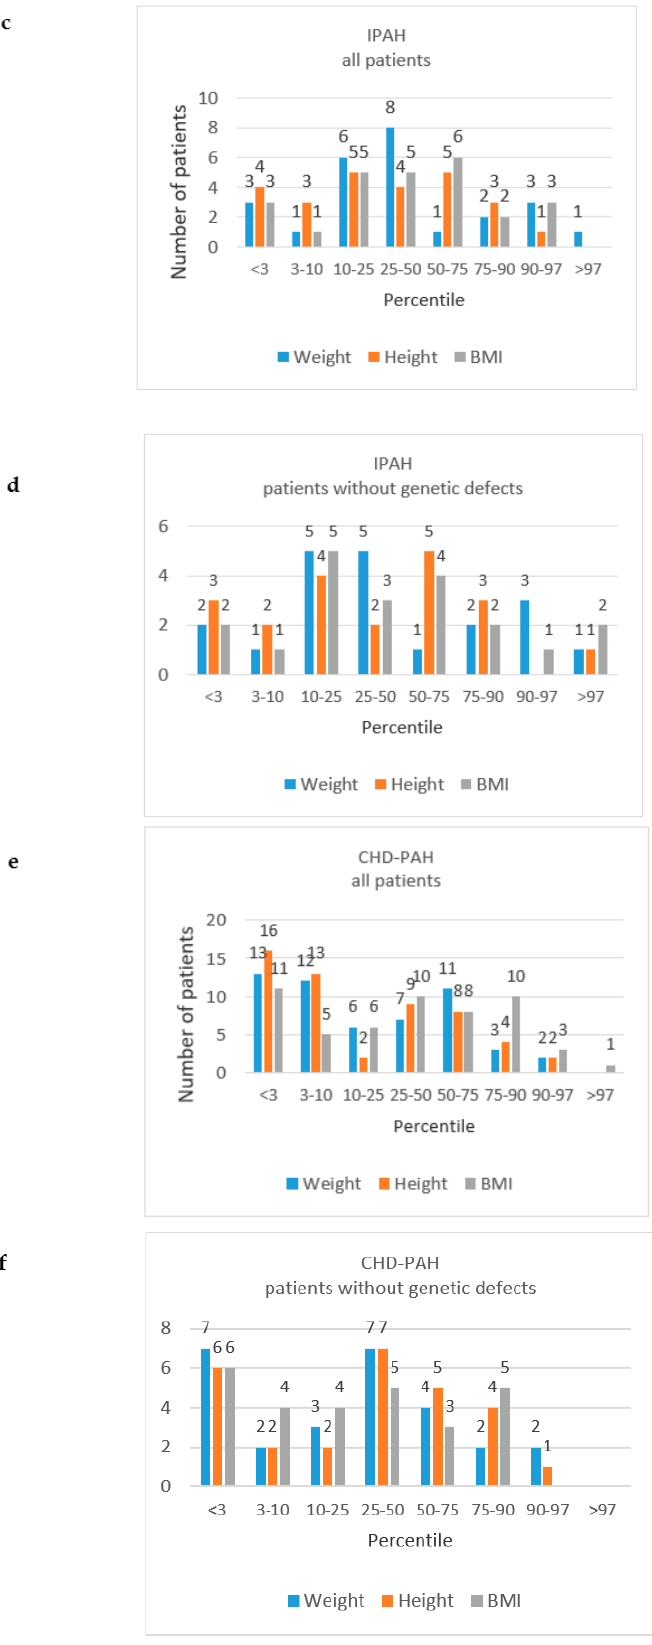
Figure 3. The distribution of the number of patients with PAH by weight, height and body mass index (BMI) percentiles, by “all patients” study groups and “patients without genetic defects” groups. ( a )